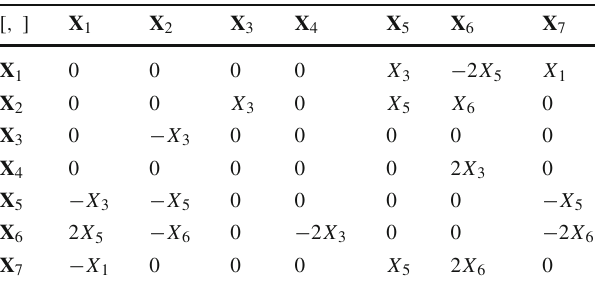
Table 1 Commutators of the admitted Lie point symmetries for the Karmarkar condition (26) [ , ]